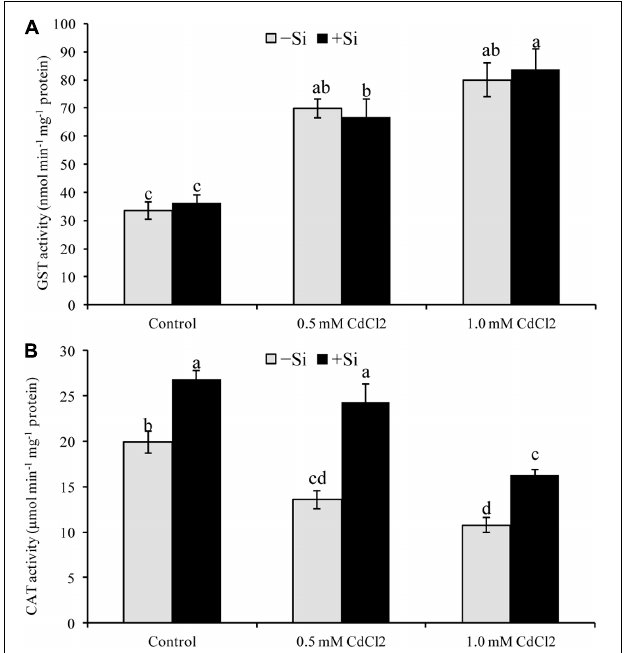
FIGURE 6 | Silicon-induced changes in the activities of glyoxalase enzymes (Gly I and Gly II activity presented in A and B , respectively) in Brassica napus seedlings grown under Cd stress. Values (Mean ± SD) of each treatment are obtained from three replications. Bars with different letters are significantly different at P < 0.05 applying Tukey’s HSD